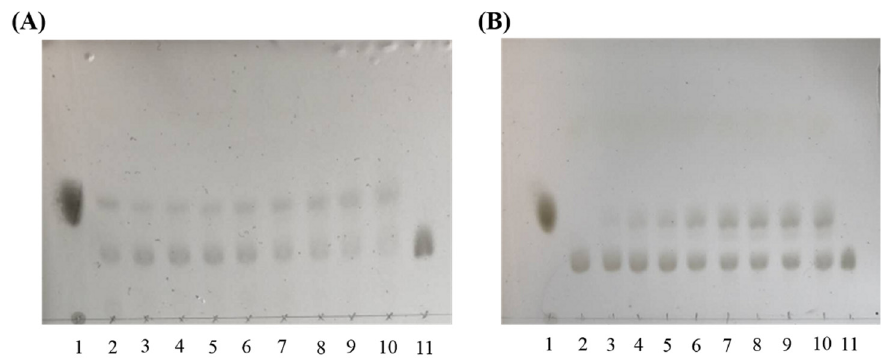
Figure 2. Analysis of α 2,3-sialyltransferase ( A ) and α 2,3-sialidase ( B ) activities of M144D by MS. For the α 2,3-sialyltransferase activity assay, the reaction mixture (800 μ L) containing Tris-HCl (100 mM, pH = 8.5), 20 mM MgCl 2 , 3 mM lactose, 3.6 mM Neu5Ac and 3.6 mM CTP was incubated with NmCSS (0.2 mg/mL) and a variant enzyme (0.25 mg/mL) at 37 °C for different periods. For the α 2,3- sialidase activity assay, the reaction mixture (800 μ L) containing MES buffer (100 mM, pH = 5.5) and 20 mM MgCl 2 was incubated with 3 mM 3 ′ -SL, a variant enzyme (2.5 mg/mL), at 37 °C for different periods. At different time points, 25 μ L of the sample was transferred into an Eppendorf tube, and 25 μ L cold ethanol was added. The mixture was kept at 4 °C for 30 min, then centrifuged at 12,000 rpm for 10 min and the precipitates were removed. The supernatants were used for analysis. All reactions were done in triplicate. 2.2. Design and Construction of M144D-Based First Generation of Mutants Considering the fact that Asp141 of PmST1 is a possible general acid/base and H311 is a possible nucleophile, their mutants were not considered for investigation (Figure 3) [26]. According to the published results, it seems that mutants (R313Y, R313H and R313N) of hydrophilic amino acid residue Arg313, which is close to the lactose acceptor in the ternary structure of PmST1-CMP-3F(axial)Neu5Ac–lactose, showed reduced α 2,3-sial- idase activities (Table 1). Specifically, Arg313 was close to His311 (Figure 4), which has been demonstrated to be critical for the α 2,3-sialidase activity but not as critical for the α 2,3-sialyltransferase activity of PmST1, and the α 2,3-sialyltransferase activity of R313Y was reduced by 40.6% and those of R313H and R313N were raised by 84.9–111.1% or 33.2%-55.3% (for different substrates) (Table 1) [26,27]. α 2-3-Sialidase activities of E271F (Glu271 is also close to the lactose acceptor according to the crystal structure) and T265S were reduced significantly too, while the α 2,3-sialyltransferase activity of E271F was not influenced too much and that of T265S was improved (Table 1). It was supposed that mu- tation(s) of Arg313 and/or Glu271 into hydrophobic residues might create a more hydro- phobic environment to discourage water molecules entering the substrate-binding pocket